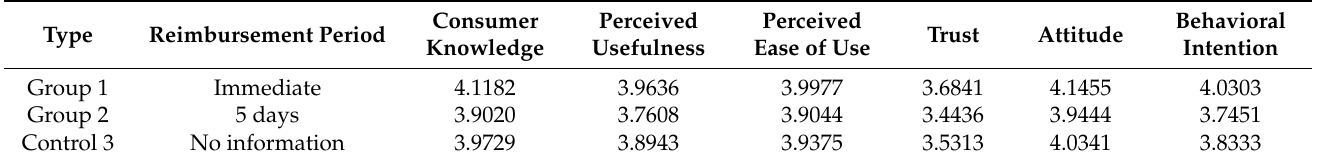
Table 7. Means for dependent variables for three different